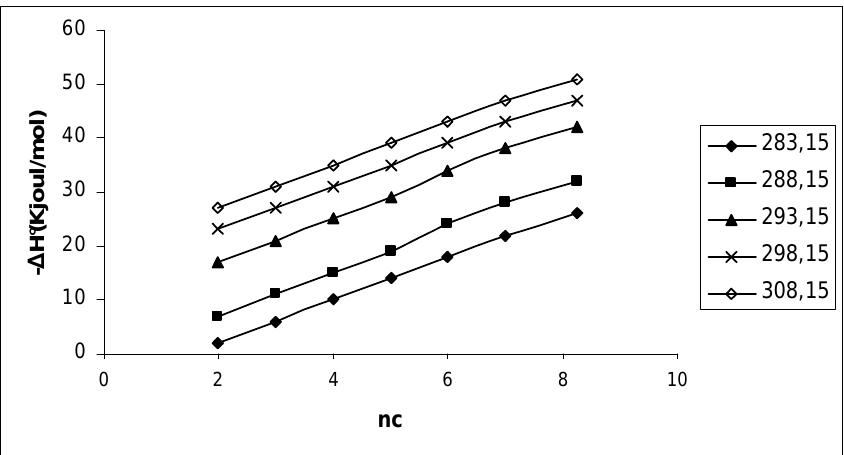
Figure 6. ∆ H° for the binding of alcohols to α -cyclodextrin against the number of carbon atoms, n c